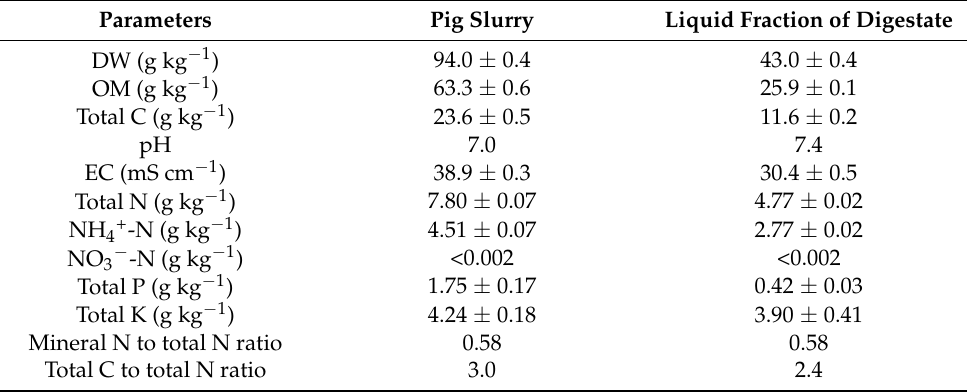
Table 1. Characterization of biobased fertilizers in fresh weight (FW) basis (mean ± standard deviation; n =